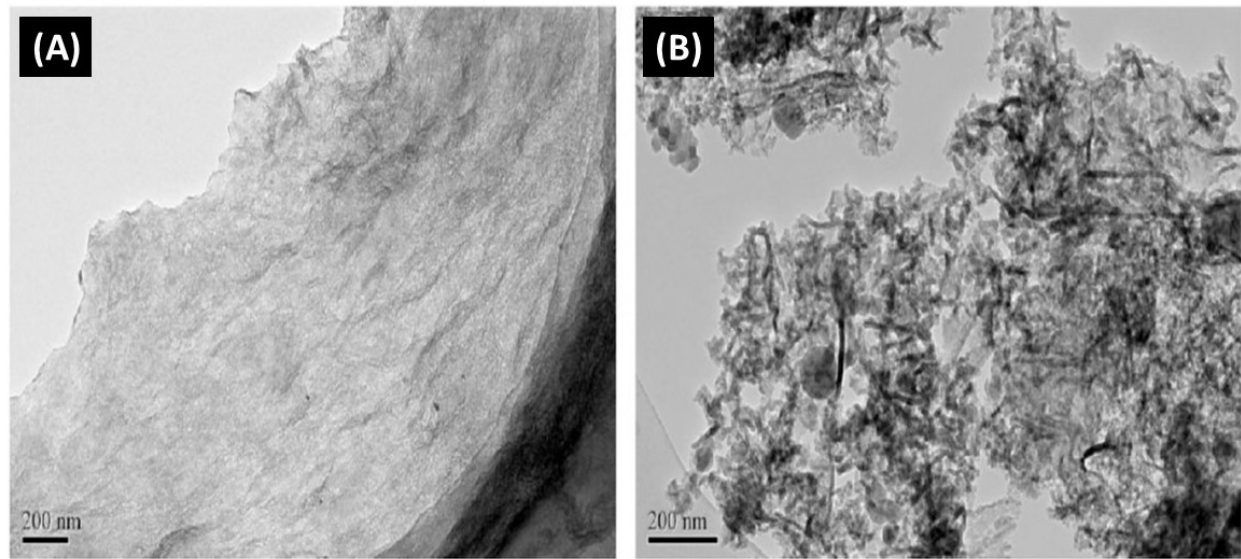
Figure 13. TEM image of ( A ) Graphene oxide (GO) nanosheets; ( B ) silicon dioxide-Graphene oxide (SiO 2 -GO) nanosheets. Reprinted with permission from ref. [57]. © 2016 Elsevier B.V.